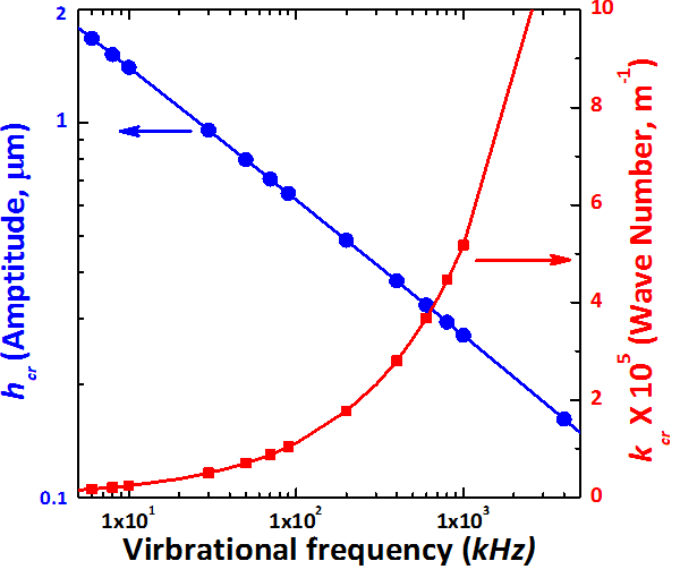
Figure 3. The dependence of the amplitude h cr and the wave number k cr with respect to the operating frequency.